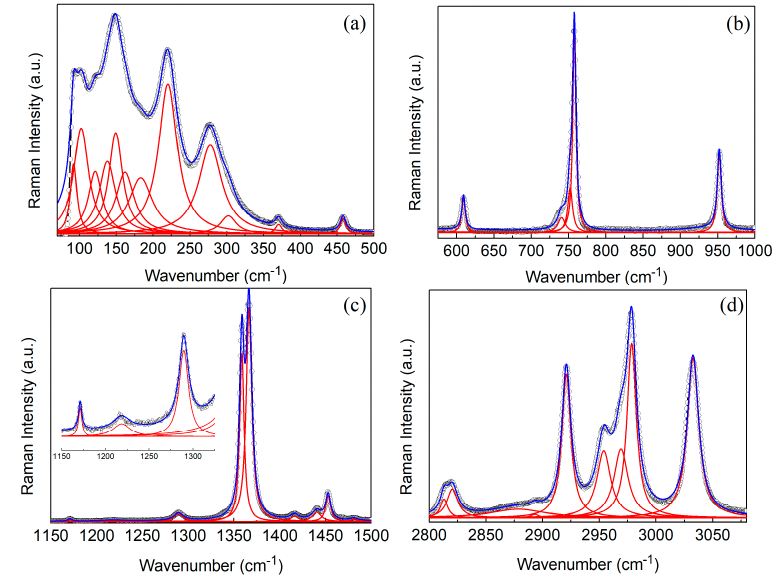
Figure 3. ( a – d ) show Raman spectra of TMACdN 3 measured at room temperature in different spectral regions. The open circles are the experimental data, while the blue line is the best fit employing Lorentzian’s function. The inset at figure ( c ) shows a zoom of the medium-wavenumber region of the spectrum.